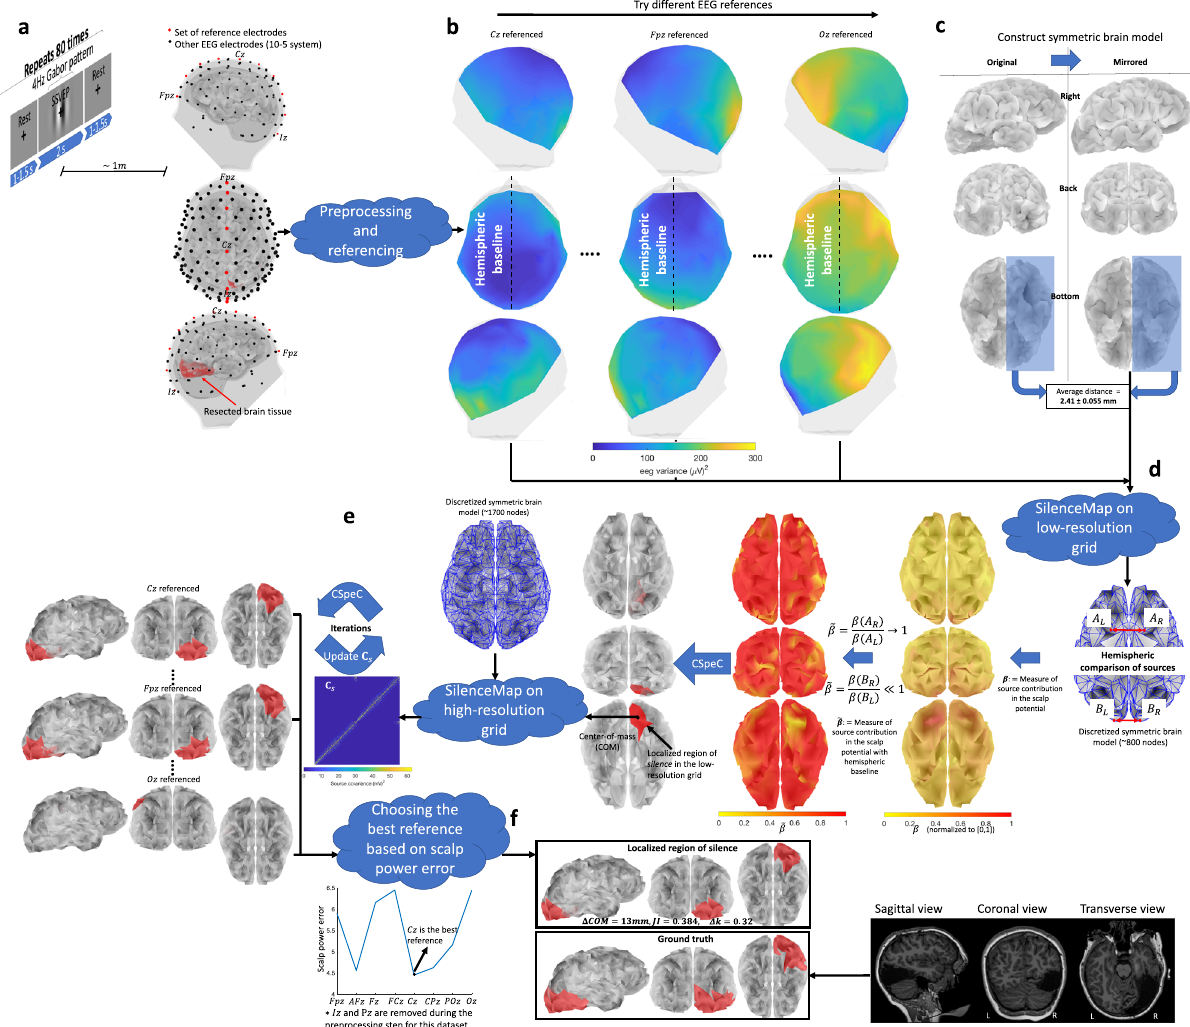
Fig. 1 SilenceMap with baseline algorithm overview. a The EEG recording protocol and the locations of scalp electrodes. One of 10 reference electrodes (shown in red) is chosen along the longitudinal fi ssure for rereferencing against. b Average power of scalp potentials for different choices of reference electrodes. c Symmetric brain model of a patient (UD) with a right occipitotemporal lobectomy. d Steps of SilenceMap in a low-resolution source grid. A measure of the contribution of brain sources in the recorded scalp signals ( ~ β ) is calculated relative to a hemispheric baseline. In the brain colormap, yellow indicates no contribution. A contiguous region of silence is localized based on a convex spectral clustering (CSpeC) framework in the low-resolution grid. e Steps of SilenceMap in a high-resolution source grid. The source covariance matrix ( C s ) is estimated through an iterative method, and the region of silence is localized using the CSpeC framework. f Choosing the best reference electrode to reference against ( Cz in this example), which results in minimum scalp power mismatch ( Δ Pow). The localized region of silence for this patient (UD) has 13 mm COM distance ( Δ COM) from the original region, with more than 38% overlap (JI = 0.384), and it is 32% smaller ( Δ k =